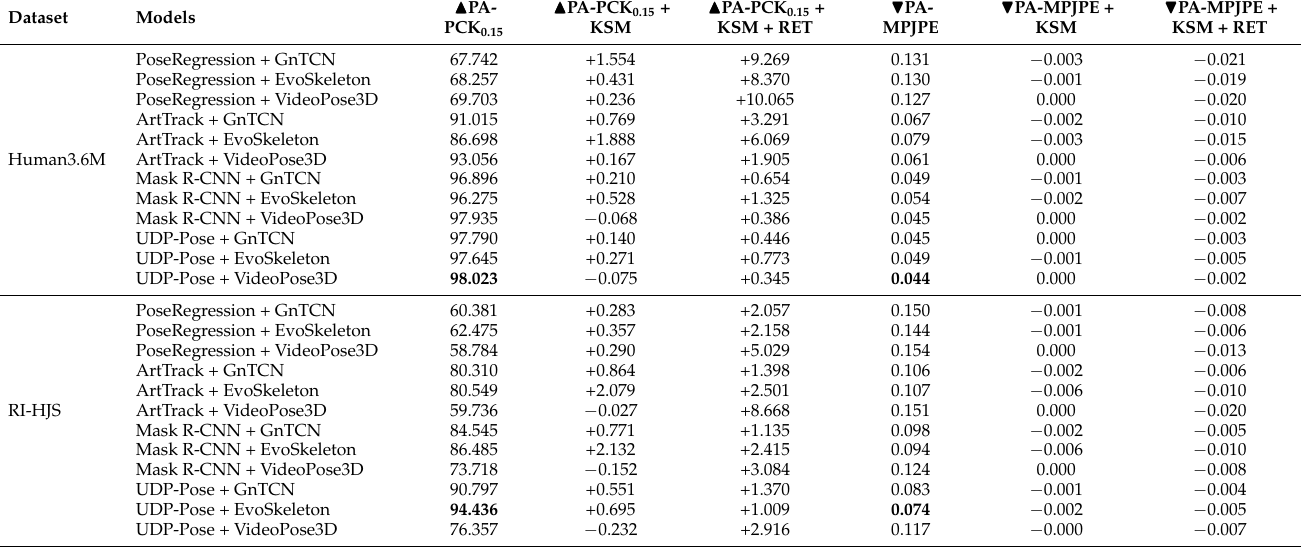
Table 4. Results of model combinations for 3D pose estimations on the Human3.6M dataset and the custom dataset of players performing handball jump-shot (RI-HJS). The best results are marked in bold. Metrics are computed on the normalized poses using the h-norm described in Sections 2.5 and 2.6 on 13 keypoints. KSM in the table is shorthand for Kalman smoother, which is applied on the predicted sequence before evaluation, while KSM + RET is shorthand for Kalman smoother applied on the predicted sequence and Retargeting applied both on predicted and ground truth